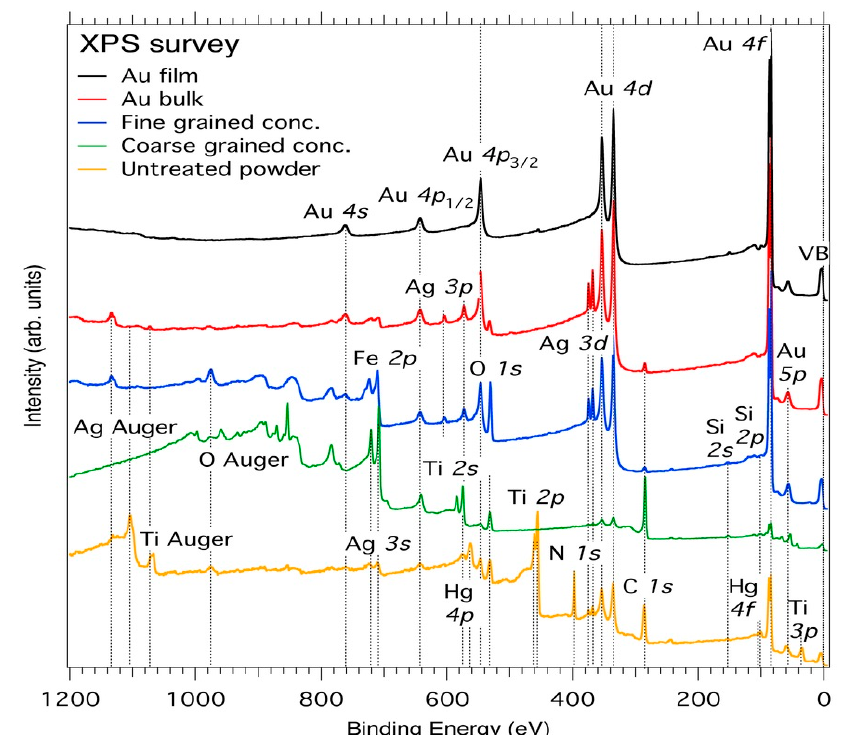
Figure 4. XPS survey spectra of film, bulk, and powder (untreated, fine, and coarse-grained concentrate) Au. The broken line connects the band edges as well as the apparent spin-orbit-splitting maxima. VB denotes valence band.